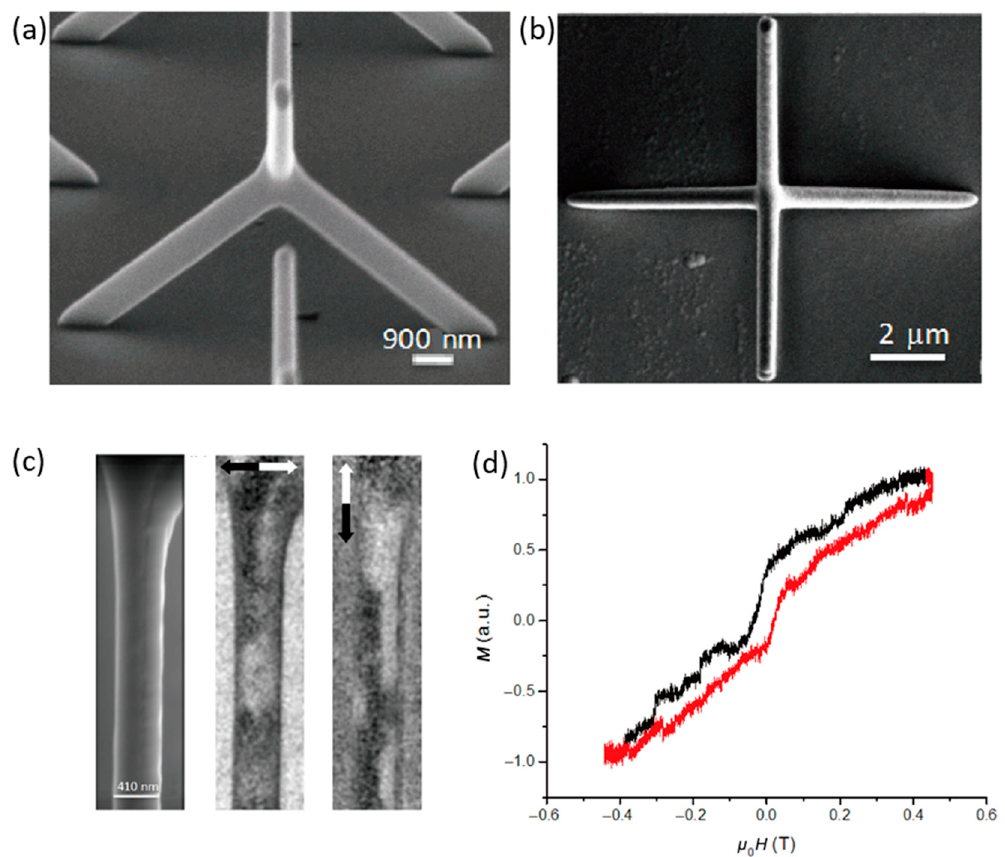
Figure 4. ( a ) Tilted SEM image of a single Co tetrapod structure; ( b ) Top-down SEM of a single Co tetrapod structure; ( c ) SEM micrograph of an individual wire within a tetrapod structure (left) and spin-polarised SEM images showing x and y-components of magnetisation in an as-deposited sample (middle and right); ( d ) Longitudinal MOKE loop obtained from tetrapod array with field applied along the projection of the lower wires onto the substrate